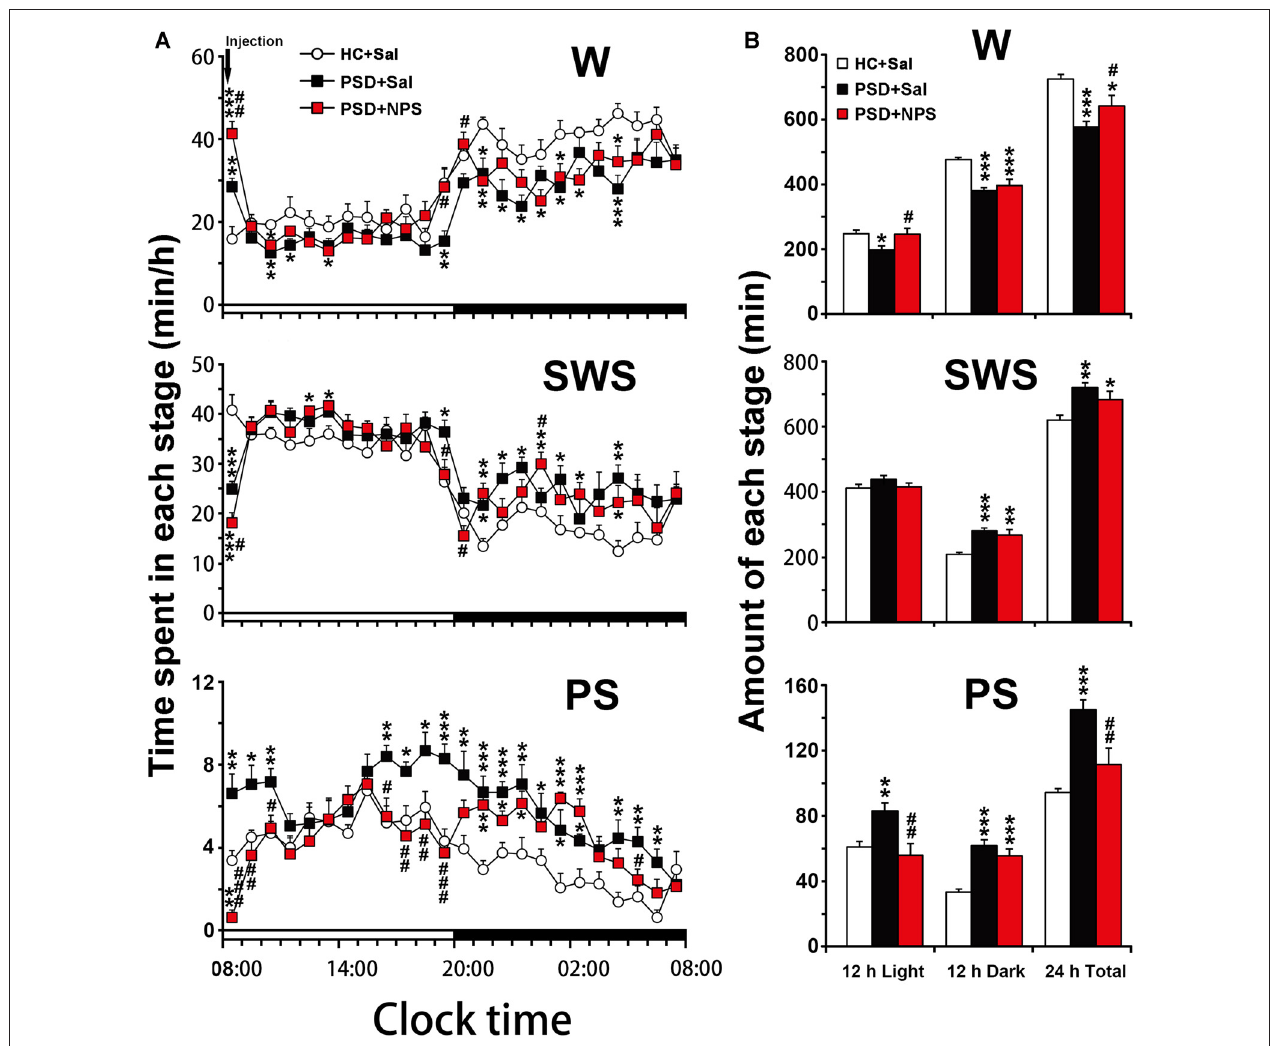
FIGURE 4 | Sleep-wake profiles of home cage control (HC) rats given saline (Sal), as well as PSD rats treated with Sal and NPS. Time-course changes in wakefulness (W), SWS and PS for 24 h (A) . The horizontal open and filled bars indicate the 12 h light and 12 h dark periods, respectively. Total time spent in W, SWS and PS during the 12 h light, 12 h dark phases and 24 h total (B) . Data are the means ± SEM ( n = 8–9). ∗ P < 0.05, ∗∗ P < 0.01, ∗∗∗ P < 0.001 compared to HC + Sal; # P < 0.05, ## P < 0.01, ### P < 0.001, compared to PSD + Sal. Statistics were analyzed by one-way ANOVA and followed by Fisher’s LSD